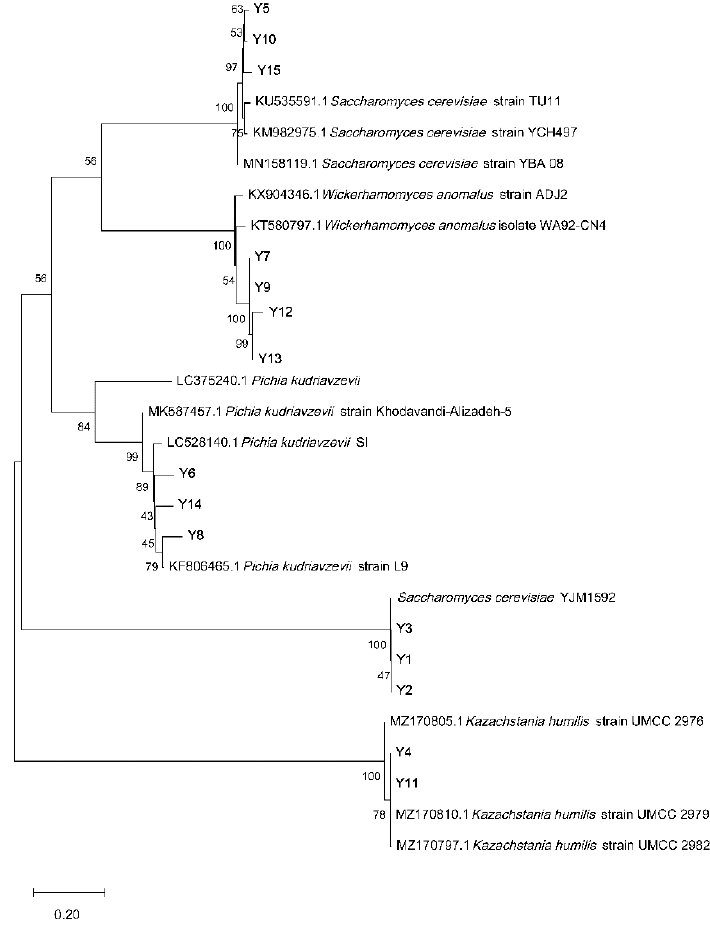
Figure 2 . Phylogenetic tree of yeast based on ITS gene sequence. Figure 2. Phylogenetic tree of yeast based on ITS gene